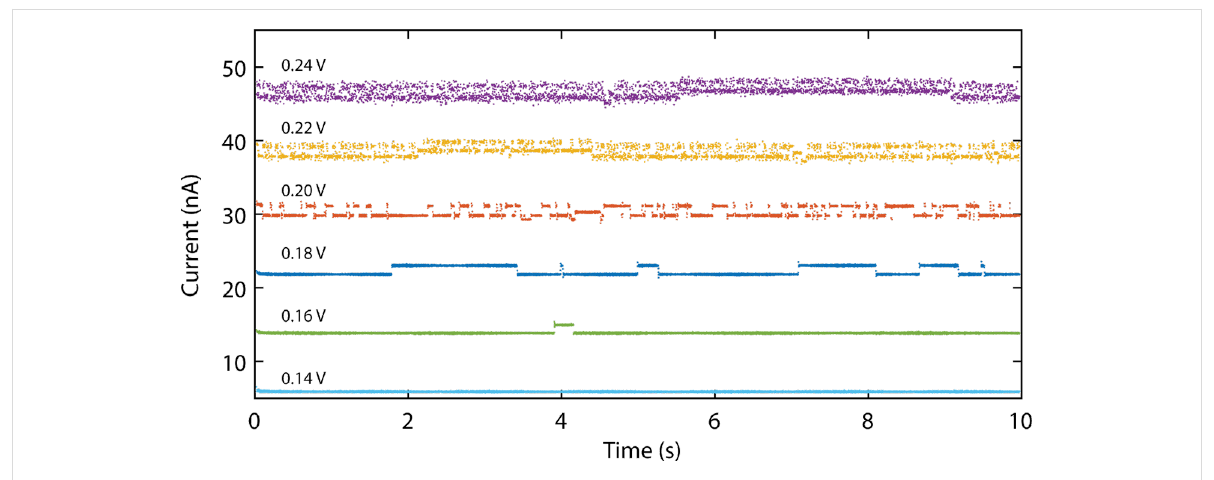
Figure 6: Current versus time traces acquired at bias voltages varying between 0.14 and 0.24 V. The traces have been offset vertically by 7 nA for clarity. Notice the increase in switching rate for higher bias voltages.